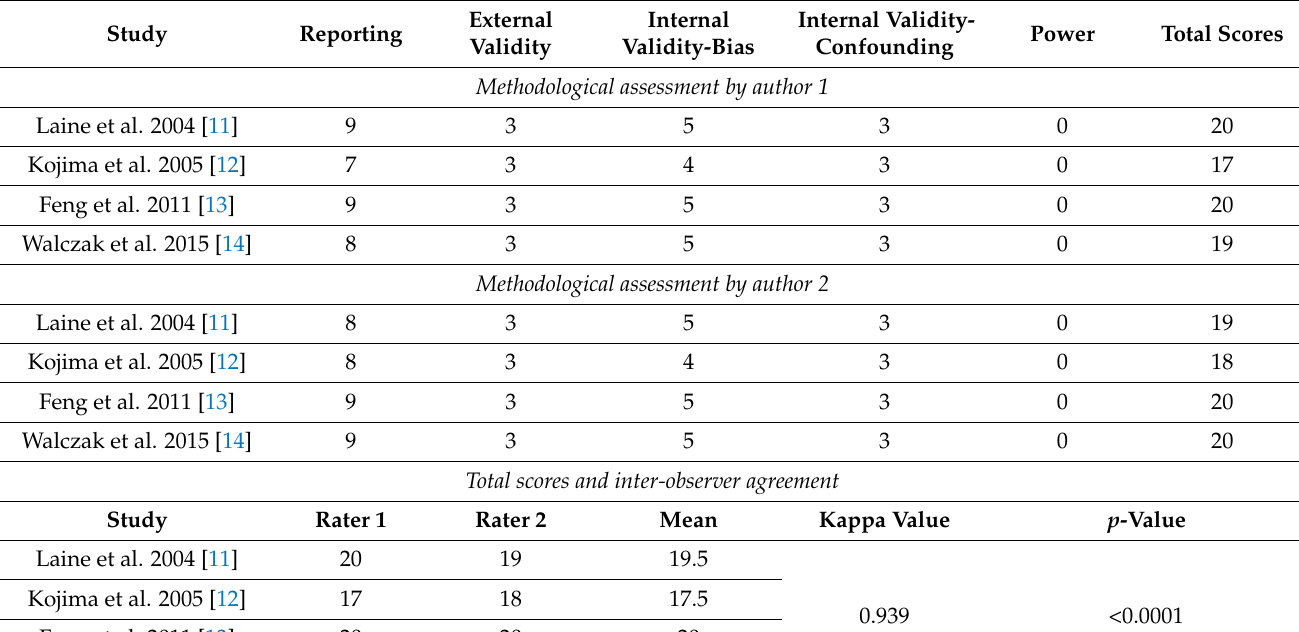
Table 2. Downs and Black scale scores for the included studies by author 1 and author 2. The total scores and inter-observer agreement are also depicted in the table.